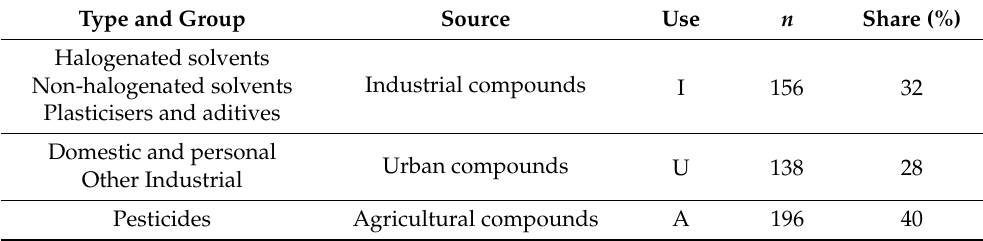
Table 5. Classification of selected compounds by group according to type, use and origin. Type and Group Source Use n Share (%) Halogenated solvents Industrial compounds I 156 32Non-halogenated solvents Plasticisers and aditives Domestic and personal Urban compounds U 138 28 Other Industrial Pesticides Agricultural compounds A 196 40